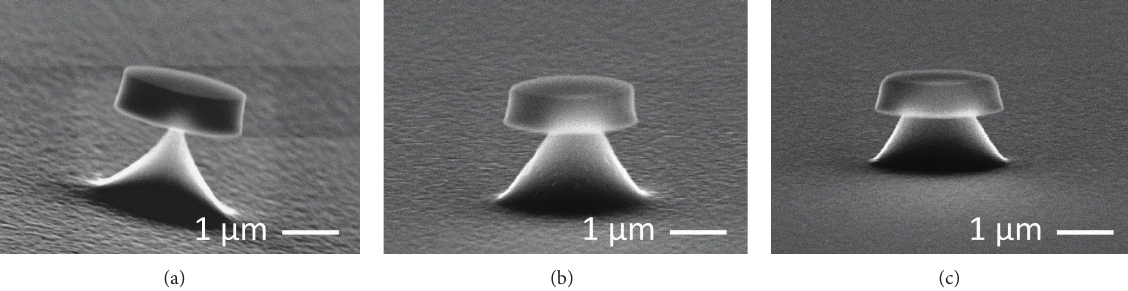
Figure 5: SEM images of tips after the Si etching with three different anisotropy factors: (a) 𝑓 = 0.4 , (b) 𝑓 = 0.5 , and (c) 𝑓 = 0.6 .